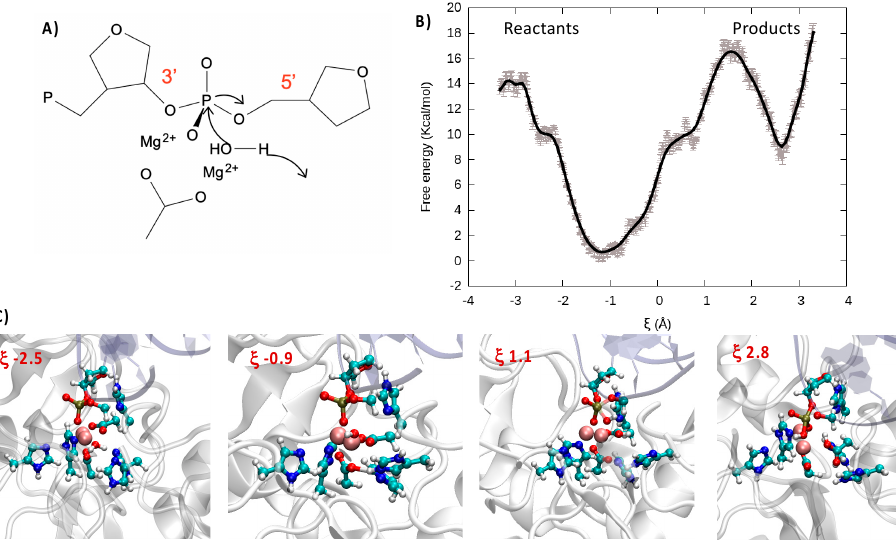
Figure 4. ( A ) Schematic representation of the catalytic attack of a water molecule to the phosphate. ( B ) FEP over the reaction coordinate obtained at DFT level of theory. ( C ) Representative snapshots along the reaction coordinate illustrating the reactant, transition state, and product region. Note that the QM partition is represented in balls and sticks.